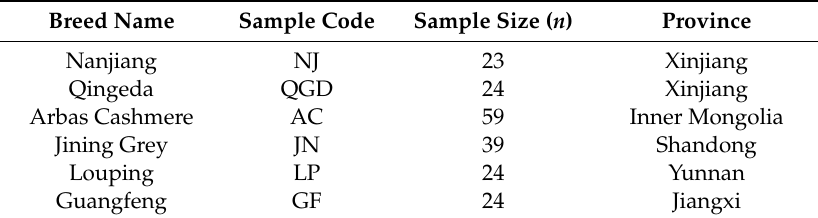
Table 1. Summary of breed name, sample code, sample size, and physical distribution of six Chinese indigenous goat populations.